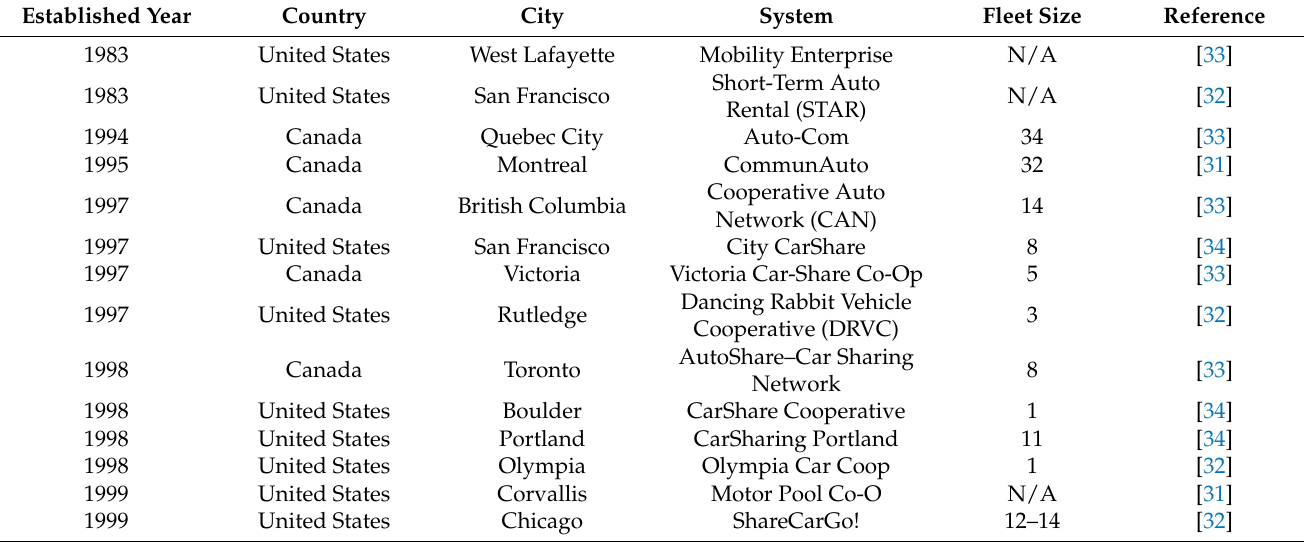
Table 2. List of selected car-sharing systems operating in North America in 1983–1999.